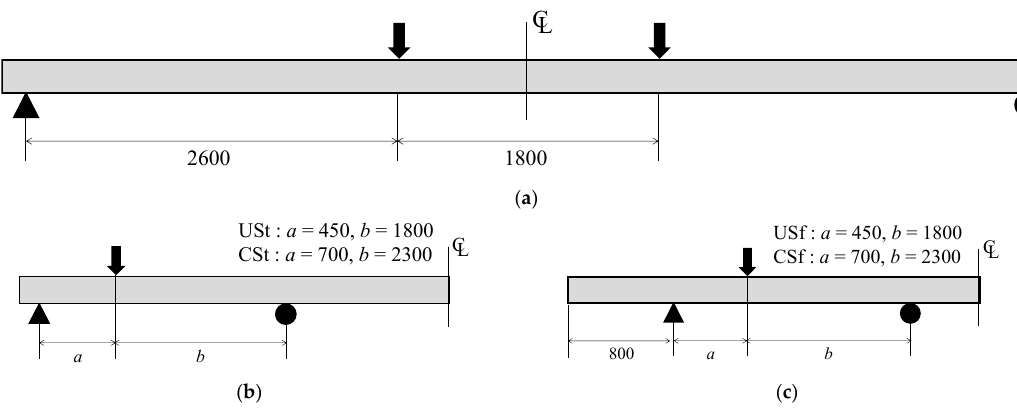
Figure 3. Test set-up (unit: mm); ( a ) UF and CF specimens; ( b ) USt and CSt specimens; ( c ) USf and CSf specimens.